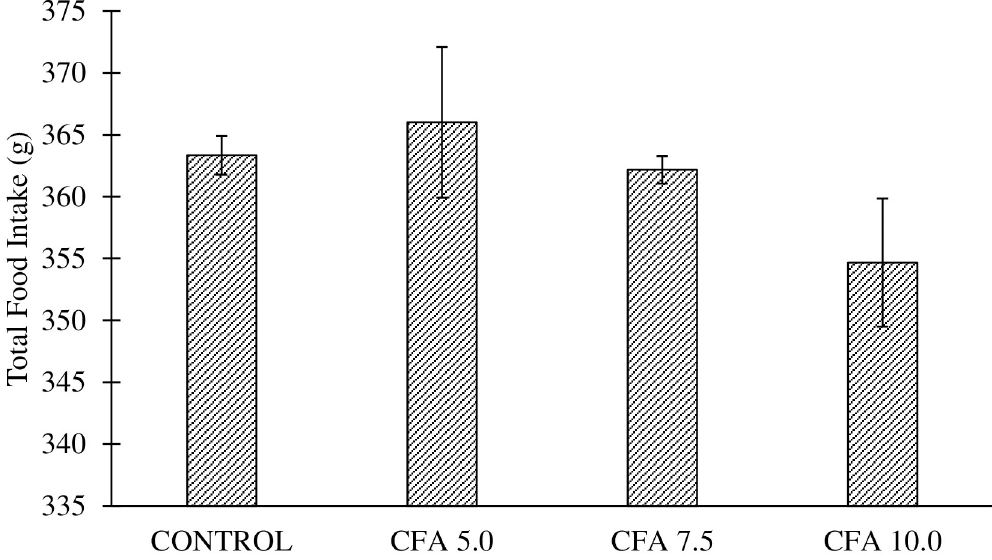
Fig 2. Total food intake in the groups for 20 days of experimentation. No significant changes were detected between the groups.